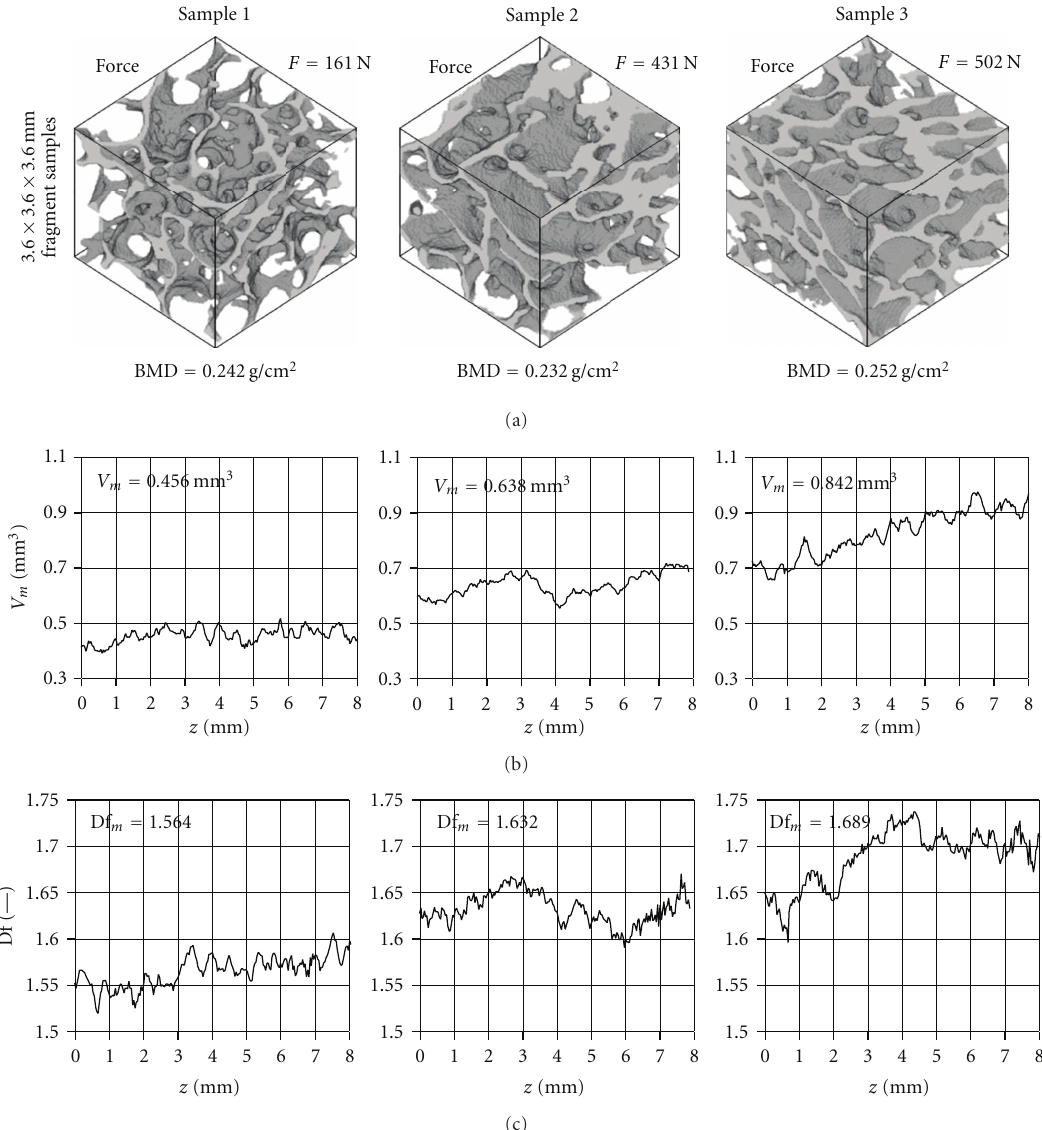
Figure 7: The structure of three selected samples: (a) curves of changes of volume V ; (b) fractal dimension Df (c) along the axes of these